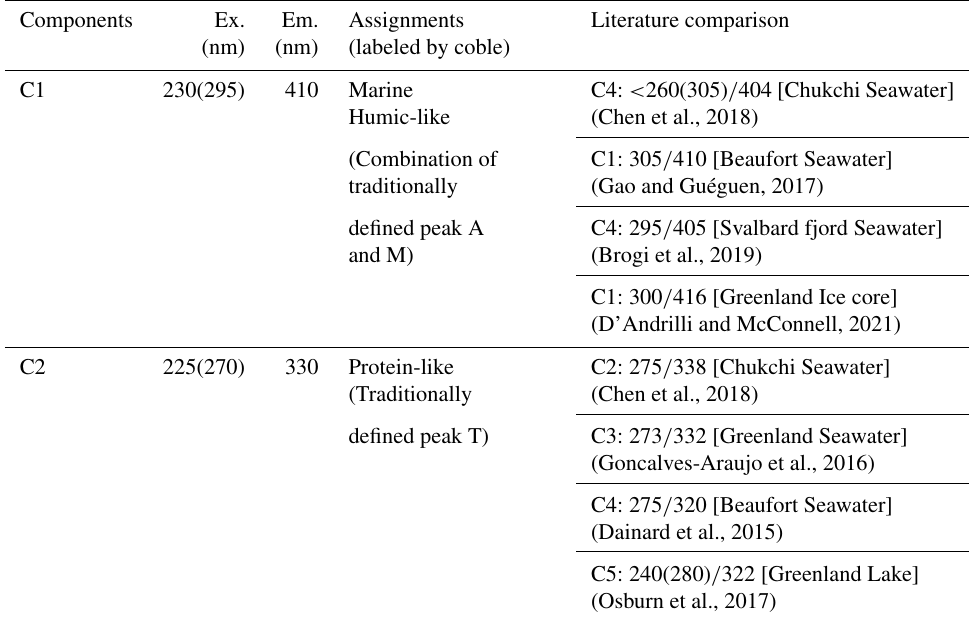
Table 1. Excitation (Ex) and emission (Em) maxima of the two fluorescent components, their assignments, and the comparison with previous